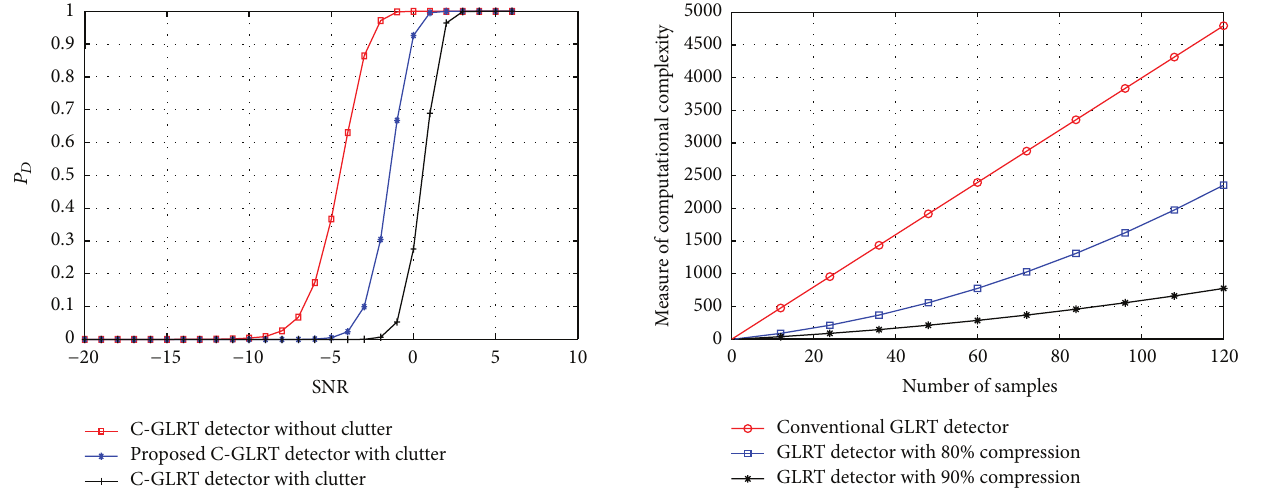
Figure 5: Comparison of computational complexities at different compression